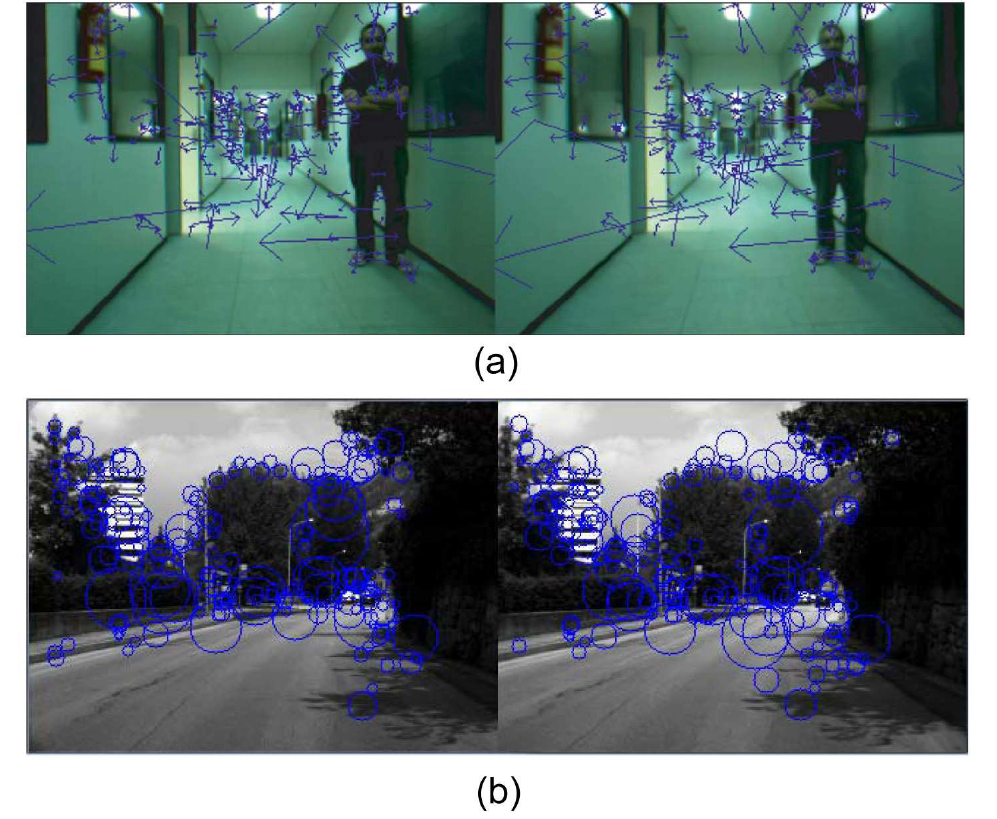
Figure 3. ( a ) SIFT features found for the left and right images from the stereo image ( F l and F r ). The scale and orientation are indicated by the size and orientation of the vectors; t ( b ) SURF features calculated using the stereo system in an outdoor environment. Scale are illustrated by the size of the circles (orientation is not shown in the